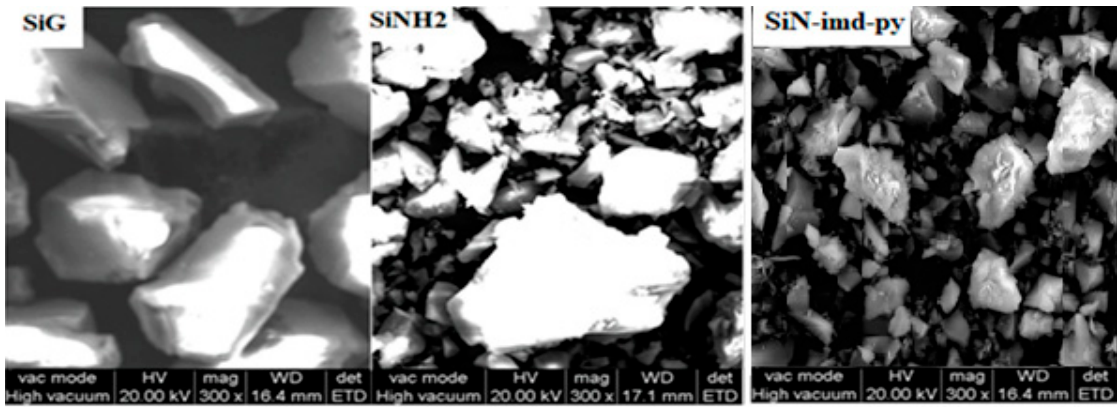
Figure 1. FTIR spectra of SiNH2 and Si-Imd-Py (before and after desorption).